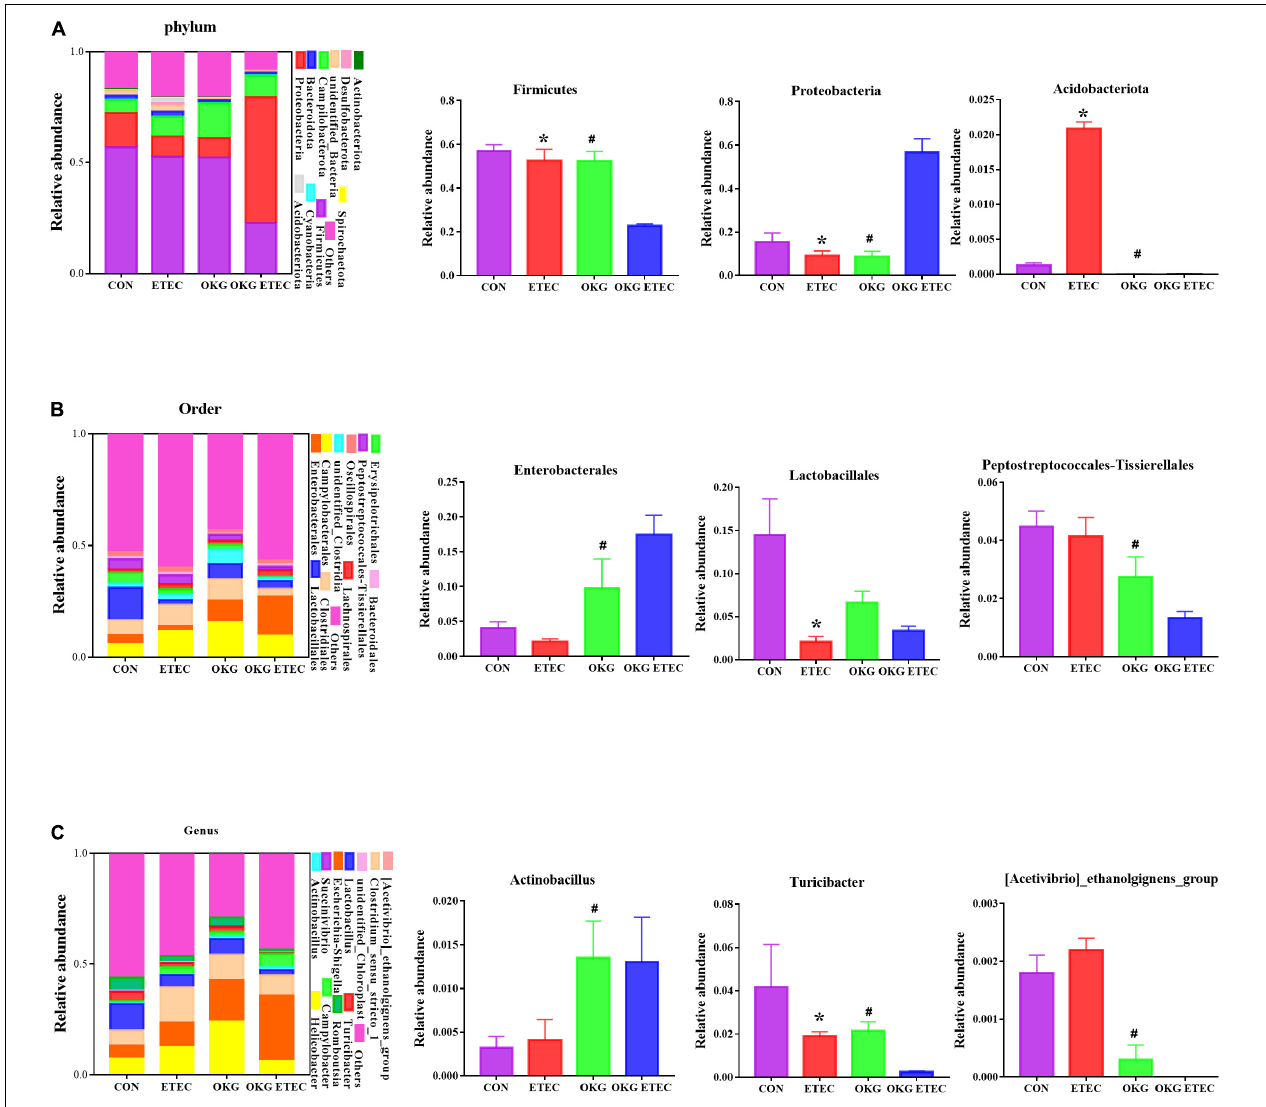
FIGURE 3 | Effects of OKG supplementation on ileal mucosa microbiota compositions at phylum, order, and genus level in ETEC-infected pigs. (A) Microbiota compositions at the phylum level, (B) microbiota compositions at the order level, and (C) microbiota compositions at the genus level. Values are presented as mean ± SEM. *Indicates a statistically significant difference for the challenge (ETEC or LB Broth) ( p < 0.05). # Indicates a statistically significant difference for dietary treatment (basal or OKG diet) ( p <